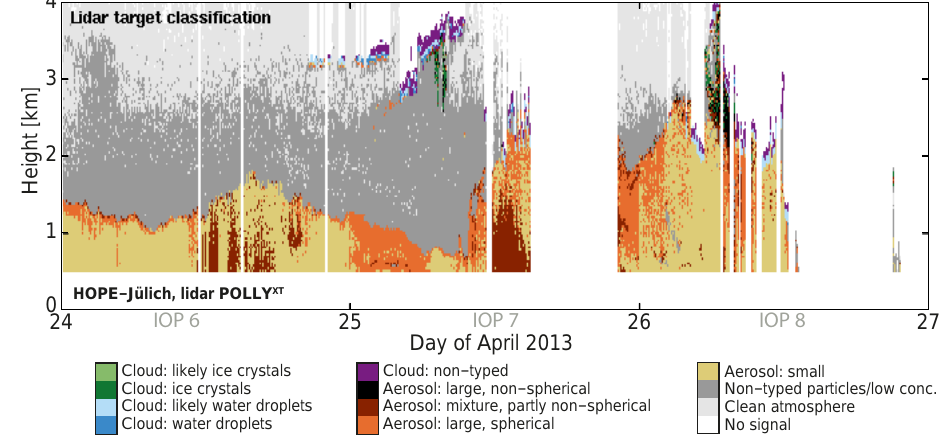
Figure 10. Aerosol target classification for the HOPE-Jülich period from 24 to 26 April 2013 (IOPs 6–8) based on continuous observations of the multi-wavelength polarization lidar Polly XT . The methodology is described in Baars et al.